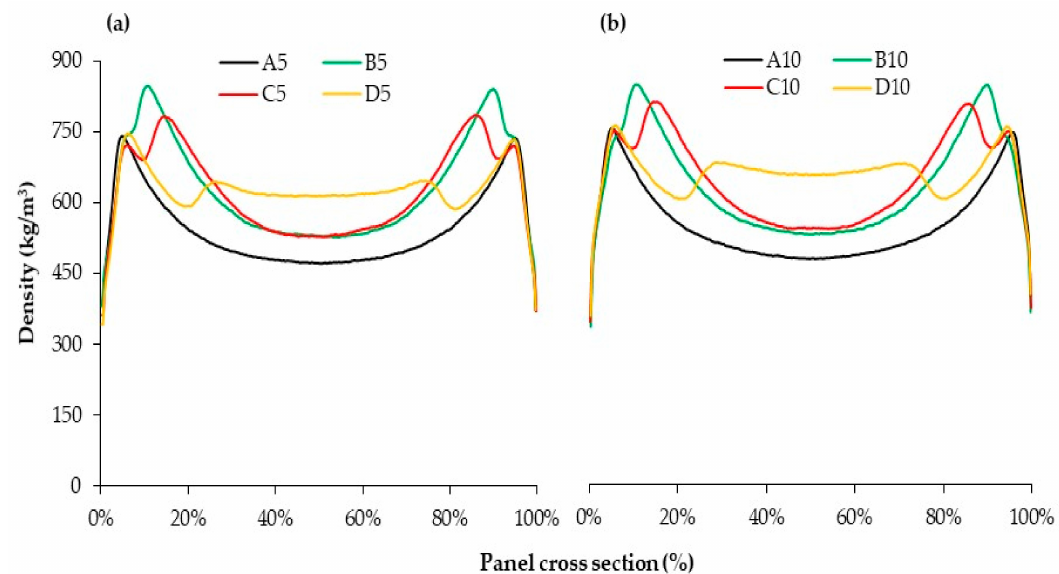
Figure 4. Density profile curves for different pressing schedules of fiberboard with different adhesive contents: ( a ) panels with 5% adhesive content; ( b ) panels with 10% adhesive